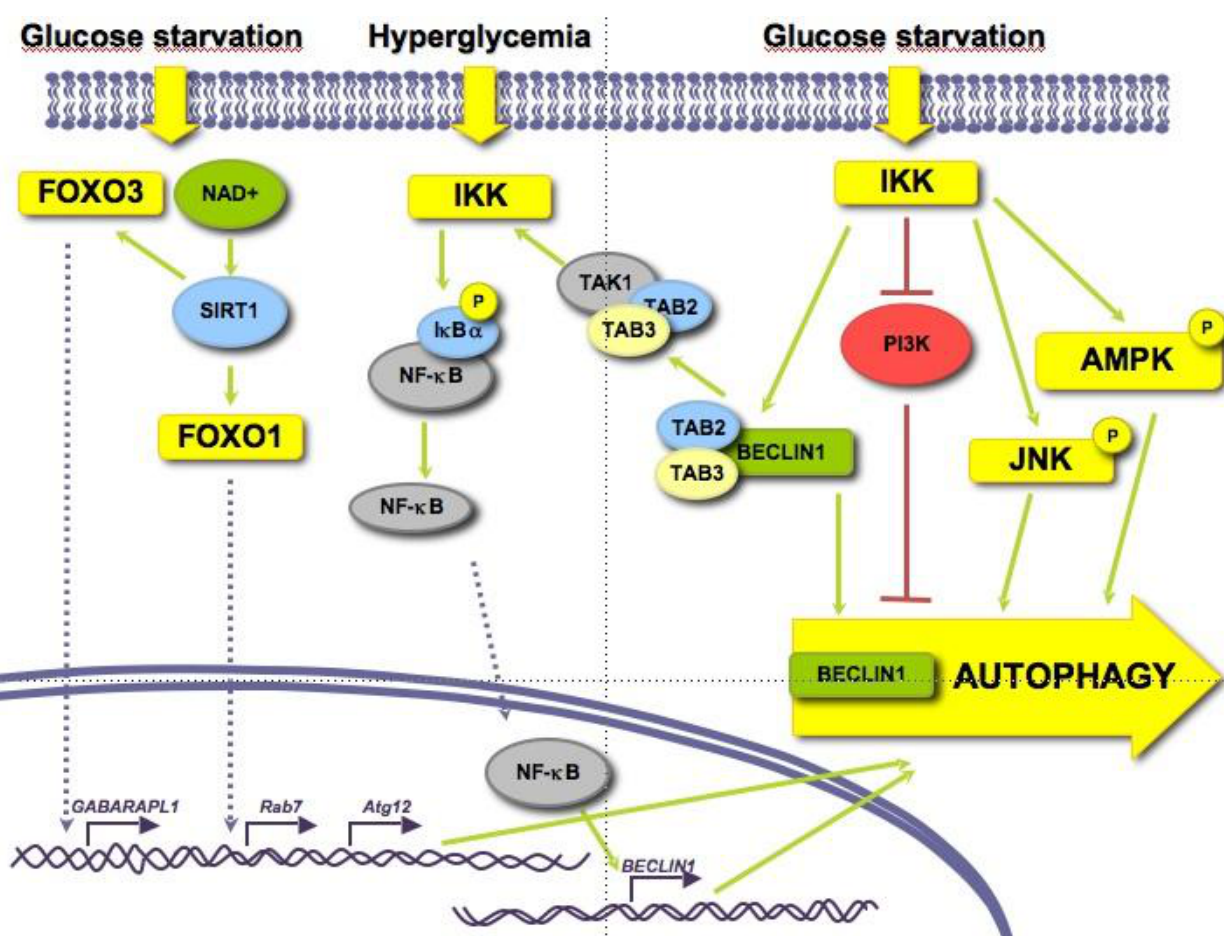
Figure 4. Other pathways involved in autophagy regulation by